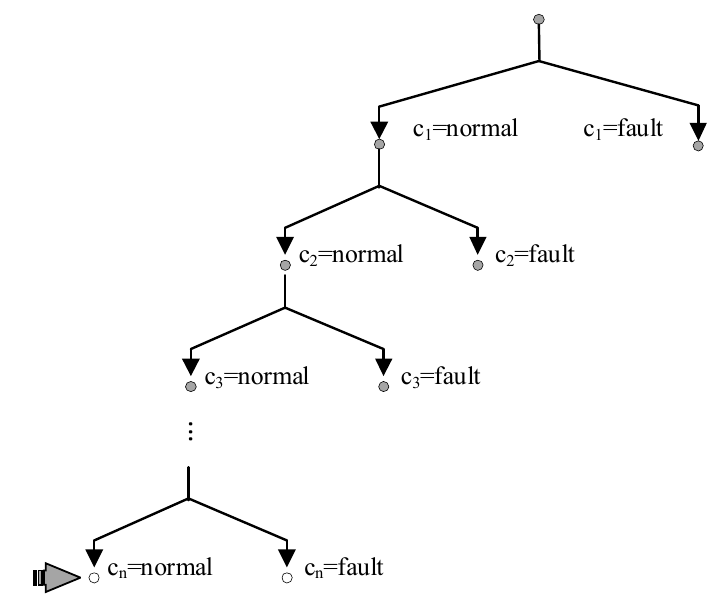
Figure 4. A Search Tree Expanded by Conflict Directed A* Search (CDA*) for Multiple Diagnoses.